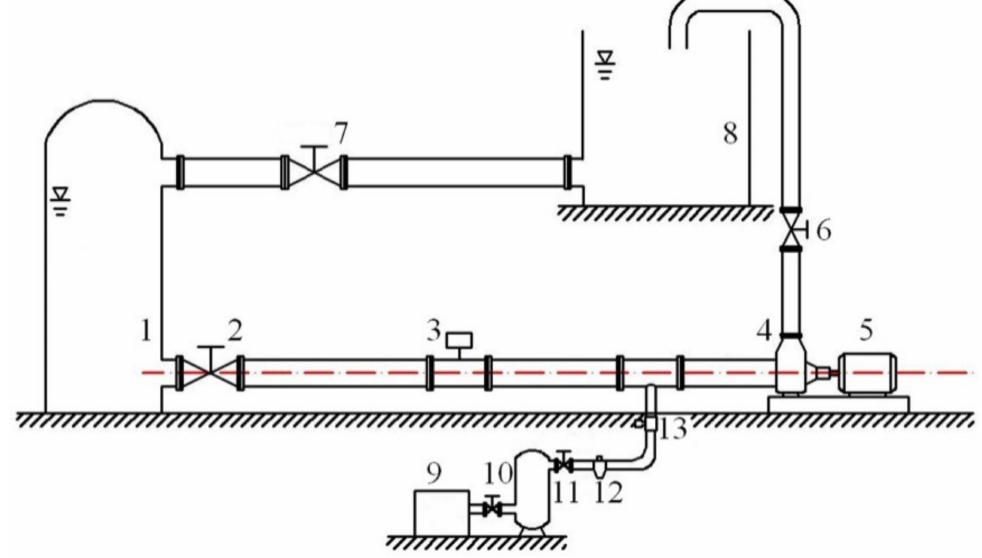
Figure 2. Schematic diagram of the test rig: 1. water tank, 2. inlet valve, 3. electromagnetic flowmeter, 4. model pump, 5. motor, 6. outlet valve1, 7. outlet valve2, 8. exhaust tank, 9. air compressor, 10. buffer tank, 11. air control valve, 12. pressure-reducing valve, 13.